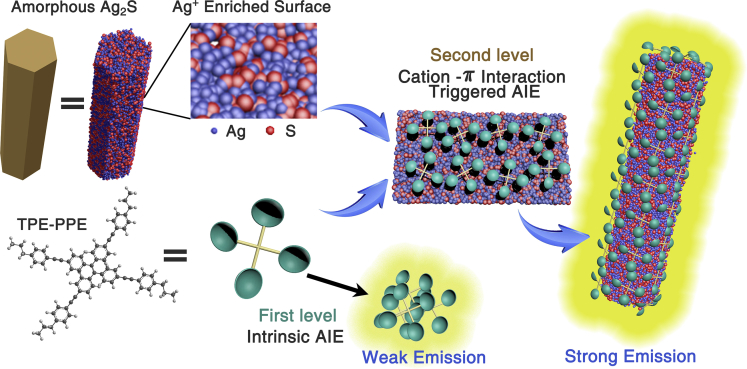
Schematic Illustration of Proposed Mechanism for Amorphous Ag2S-Induced AIE Behavior through Ag-π Interaction between Ag2S Surface and TPE-PPE